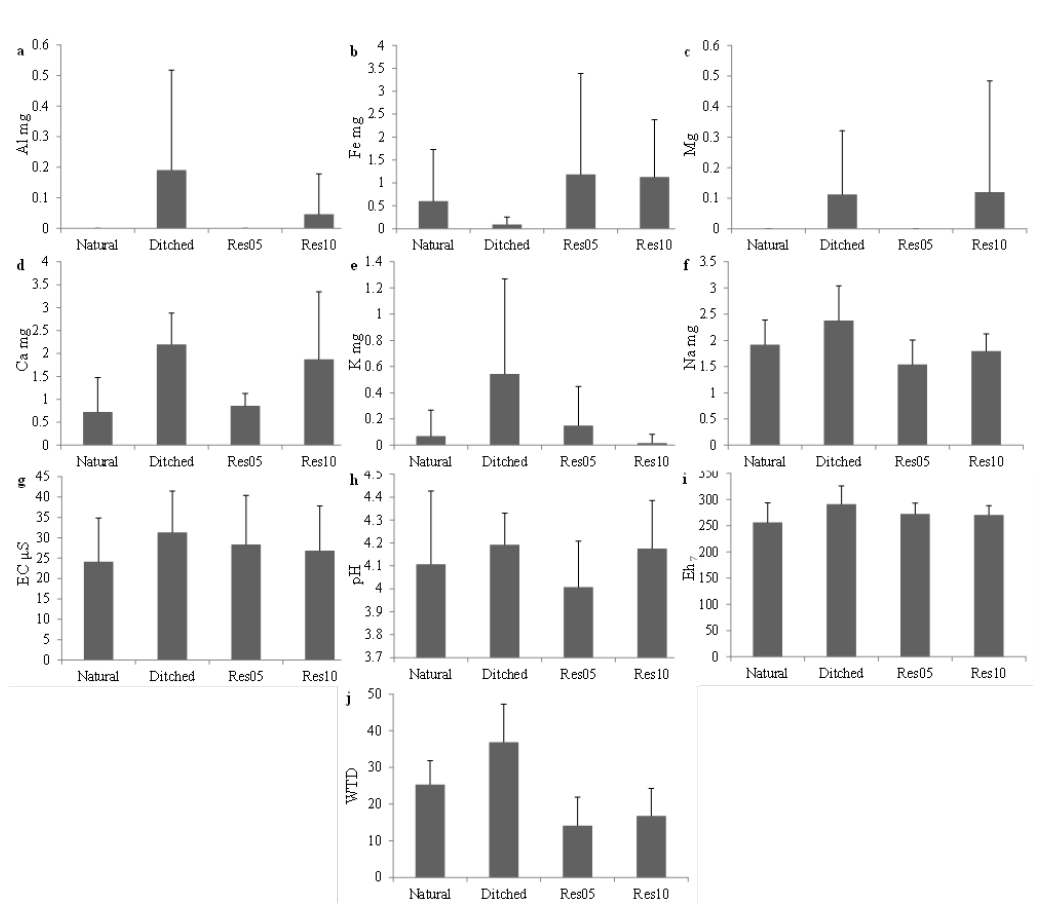
Figure 3. Average values and standard deviations of the environmental variables measured for each land use management class: (a) aluminum, (b) iron, (c) magnesium, (d) calcium, (f) potassium, (g) conductivity, (h) pH, (i) redox potential, (j) water table depth. Res05: peatlands restored 3–7 years ago; Res10: peatlands restored 9–12 years